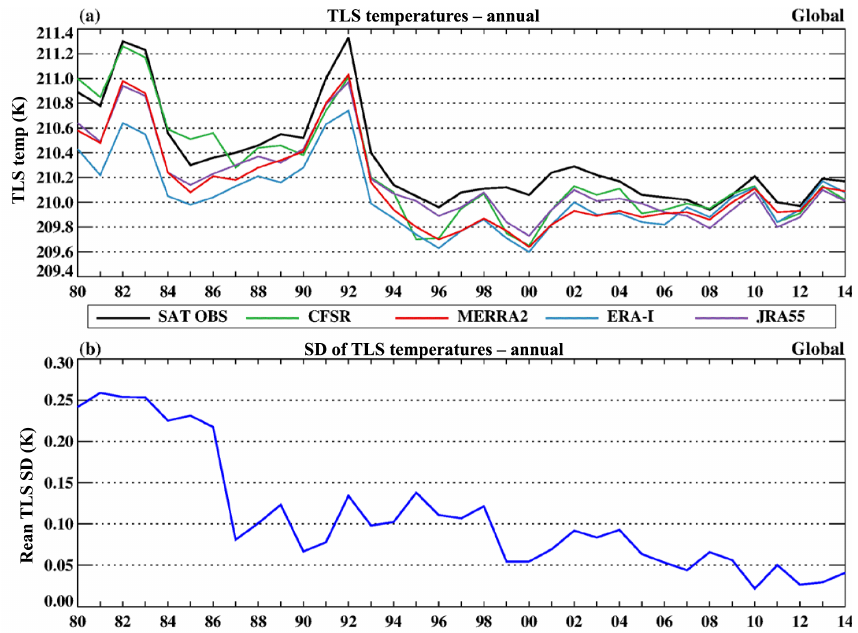
Figure 19. Time series plot of the (a) global annual average of the lower stratospheric temperature layer (TLS) temperatures ( ◦ C) for MERRA-2, ERA-Interim, JRA-55, CFSR, and the NOAA STAR TLS CDR. (b) The TLS temperature SD (K) of the four reanalyses for each year. The climatological period spanned from 1981–2010. COSMIC GPSRO observations began to be assimilated in